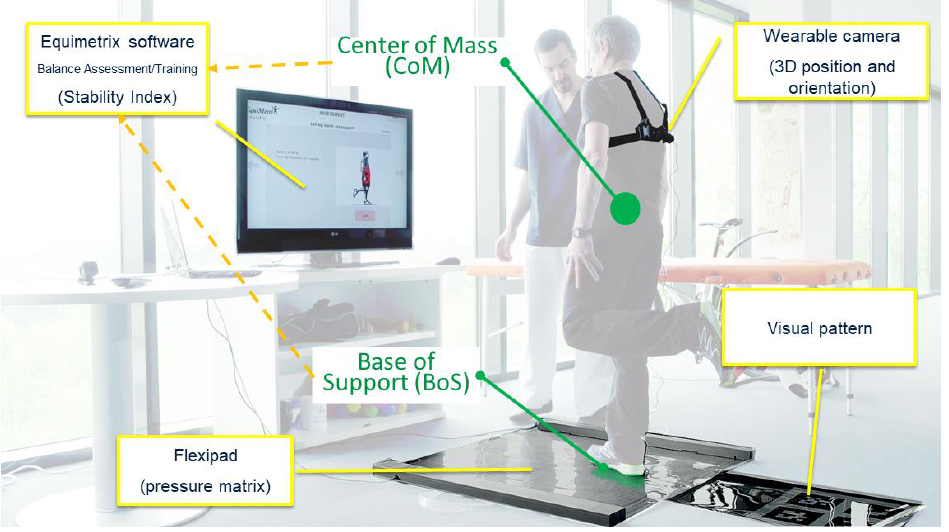
Figure 1. Equimetrix main components: sensing mat, wearable camera, and reference visual pattern.